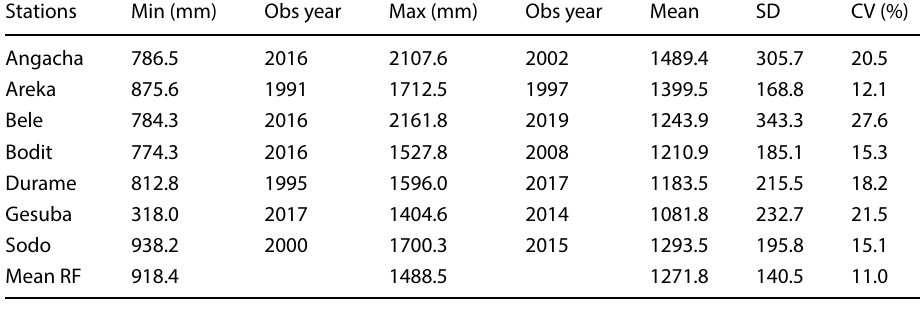
Fig. 5 Linear trend of mean annual RF of the watershed